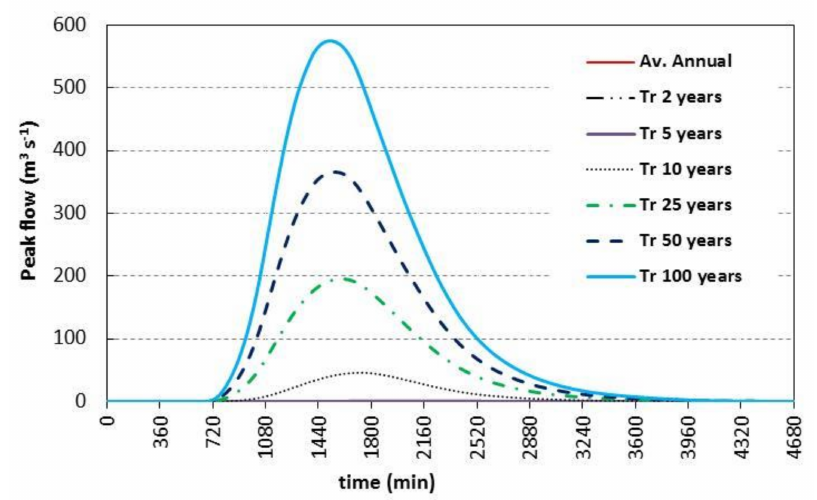
Figure 5. Runoff discharge for W. El Aawag watershed for different recurrence